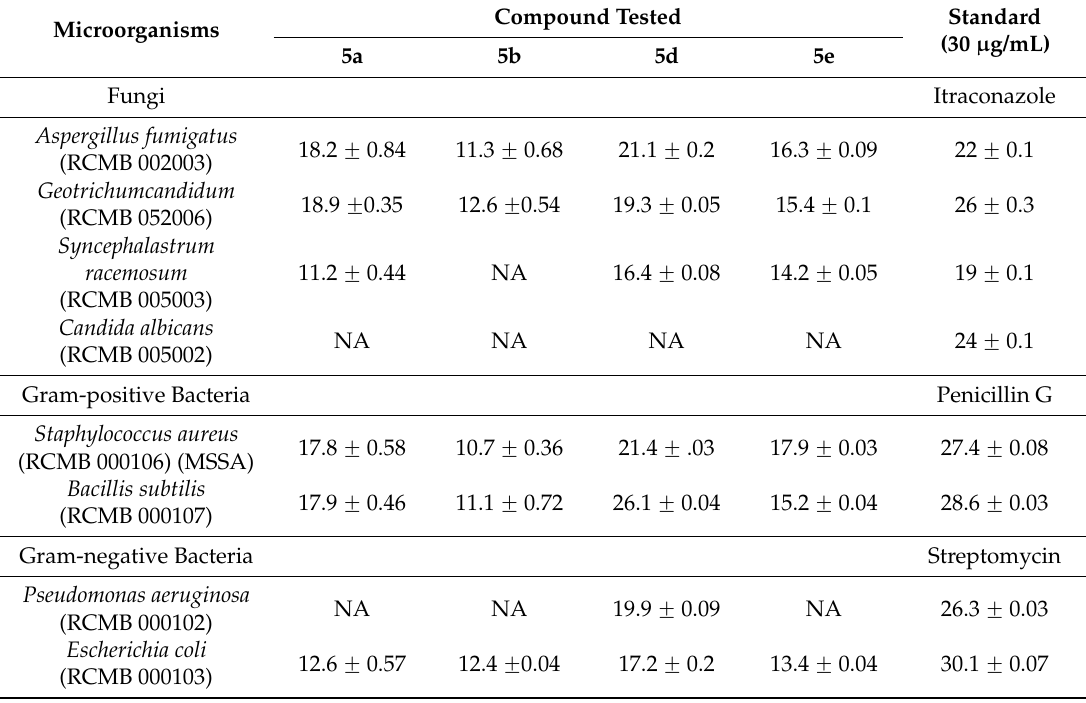
Table 1. Antibacterial and Antifungal Activities of the Synthesized Compounds. Compound Tested Standard Microorganisms